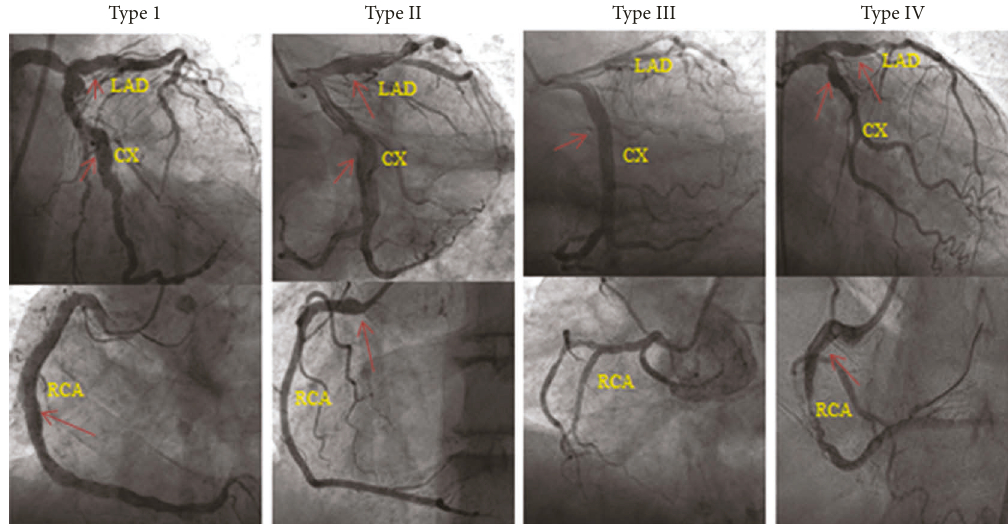
Figure 1: Angiographic features of ectatic coronary arteries according to the Markis classification. Type I: diffuse CAE in two or three coronary arteries (diffuse ectasia in LAD and CX and local ectasia proximal LAD). Type II: diffuse CAE in one coronary artery (CX) and localized CAE in other arteries (proximal LAD, CX). Type III: diffuse CAE in only one coronary artery (RCA). Type IV: localized or segmental CAE (proximal LAD, CX, and RCA) (red arrows point to ectatic segments). CAE, coronary artery ectasia; LAD, left anterior descending; CX, circumflex artery; RCA, right coronary